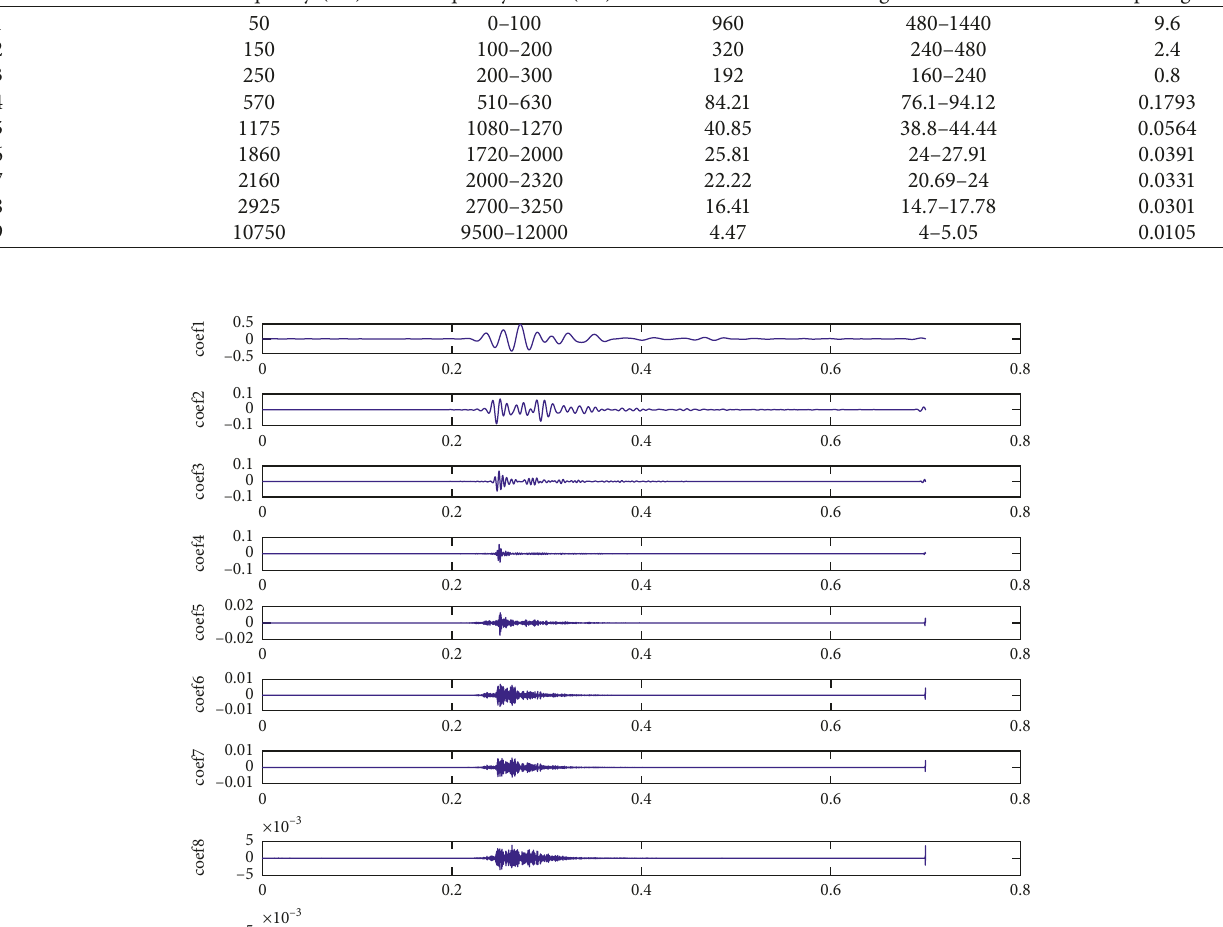
Table 5: Mother wavelet parameter of door closing sound sample. Wavelet no.